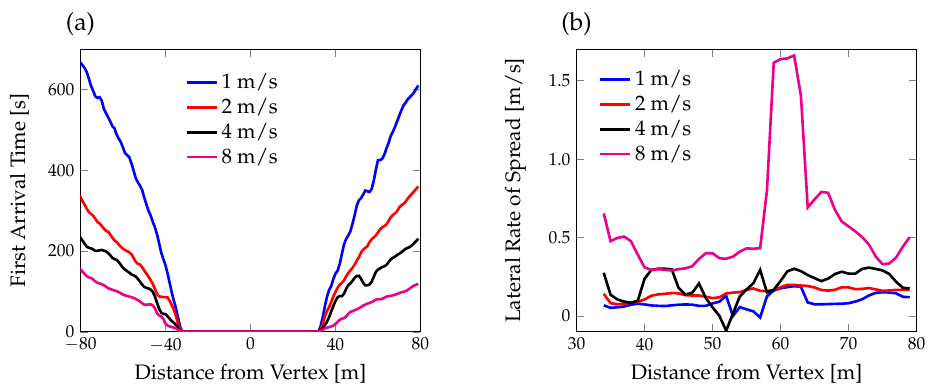
Figure 10. ( a ) The first arrival time along the horizontal line that passes through the ignition pattern. Heat maps of the first arrival time are in Figure 9. ( b ) The rate of spread, defined using (7), along the horizontal line passing through the ignition pattern. The rate of spread is only reported for the right-moving flank, and the left-moving flank has a similar